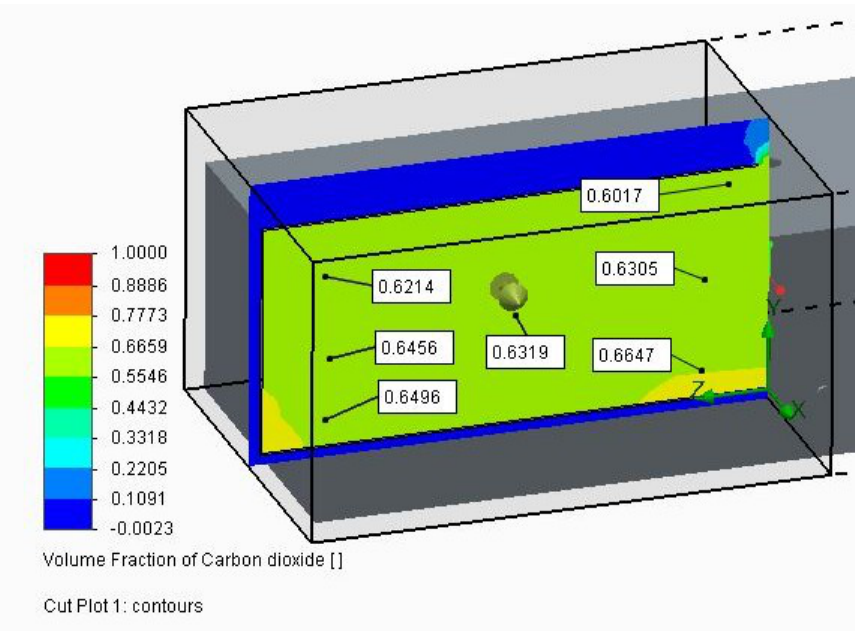
Figure 5. Vertical cut plane results at one time constant (5 min) at the center of the chamber for the same analysis shown in Figure